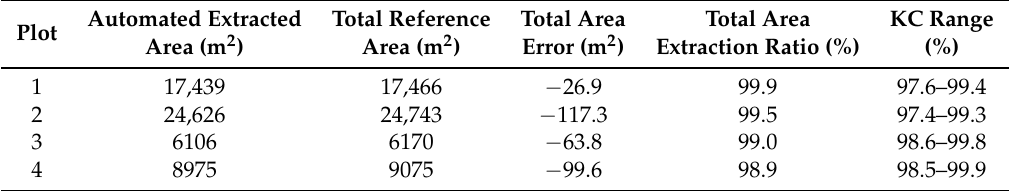
Figure 15. Extracted strips of four plots filled with different colors. ( a ) Plot 1, ( b ) Plot 2, ( c ) Plot 3, ( d ) Plot 4. Table 8. Accuracy assessment of strip